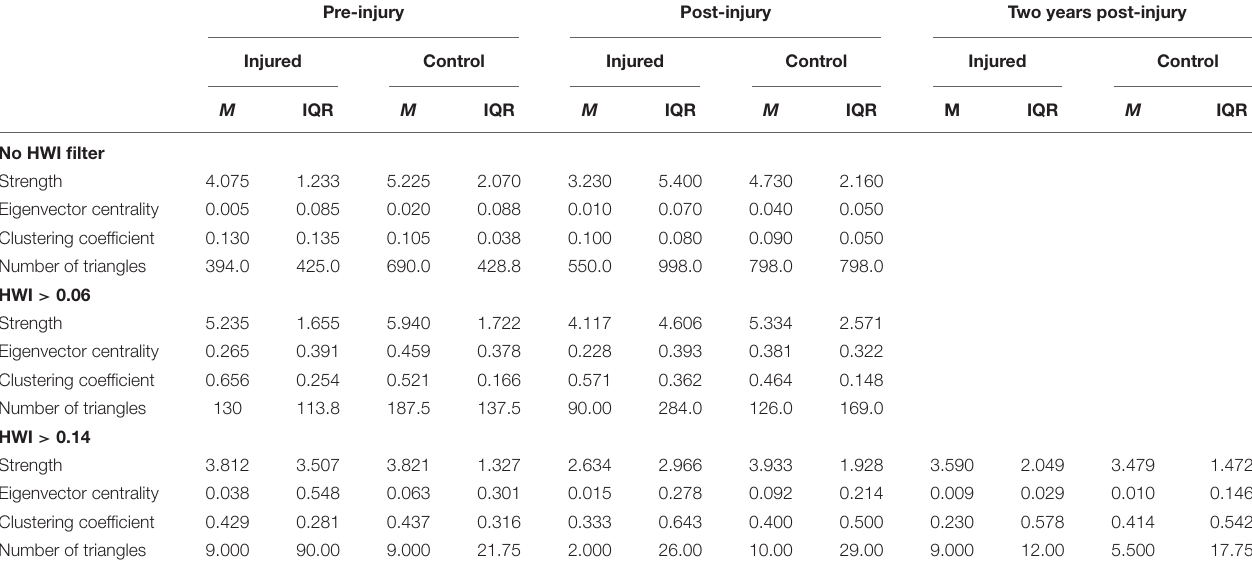
TABLE 2A | Social network analysis results.